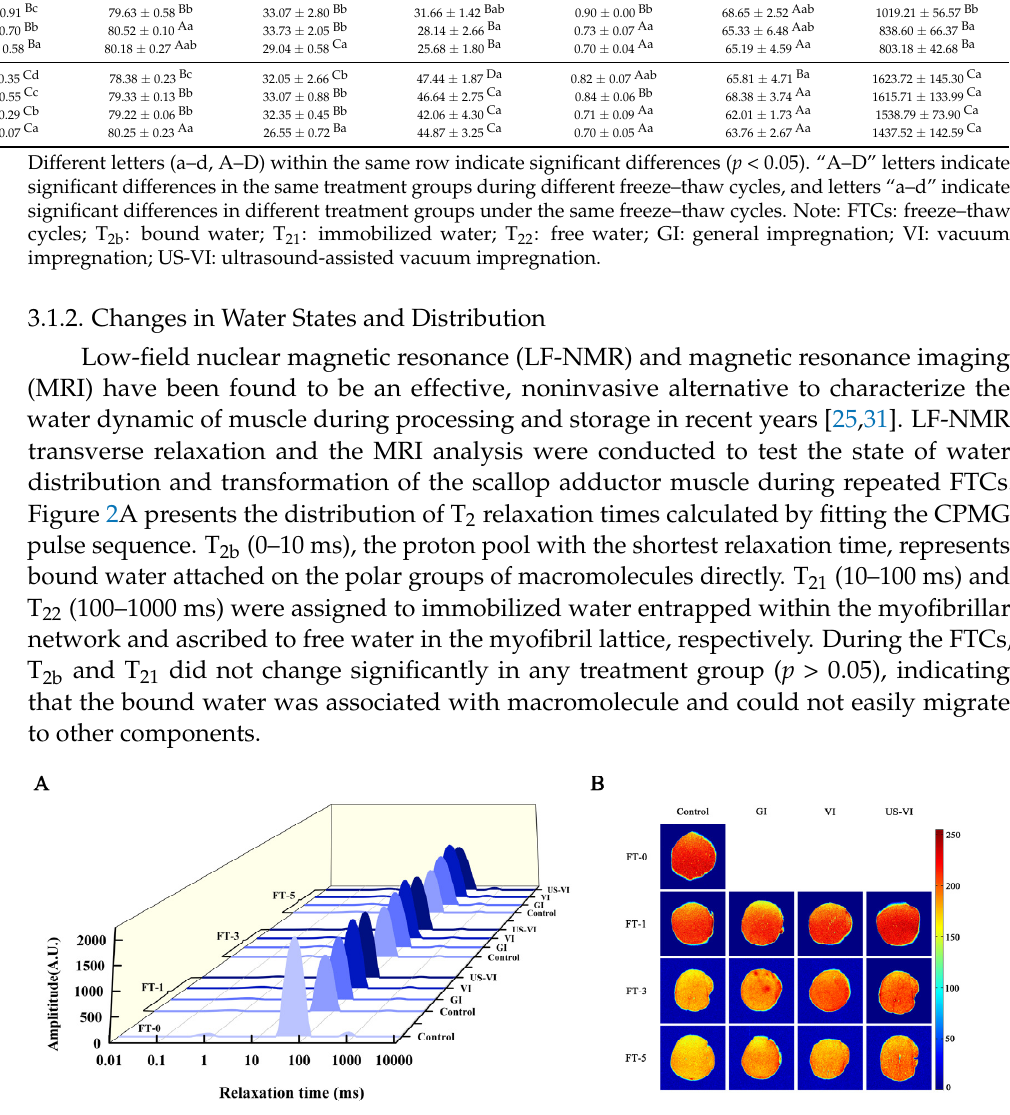
Figure 2. Changes in the water states and distribution of the scallop adductor muscle induced by freeze–thaw cycles. (( A ) The T 2 relaxation time curves of different water states; ( B ) T 2 weighted magnetic resonance images; FT-0, 1, 3, and 5: number of freeze–thaw